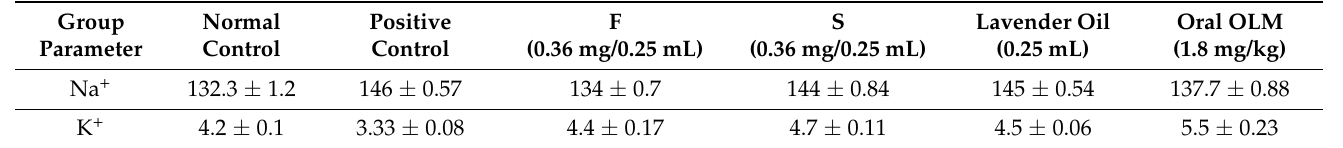
Table 3. Effect of effective dose of OLM oleogel formulation F (0.36 mg/0.25 mL) on serum level of Na + and K + vs. OLM standard gel S (0.36 mg/0.25 mL), lavender oil, and oral OLM market tablet